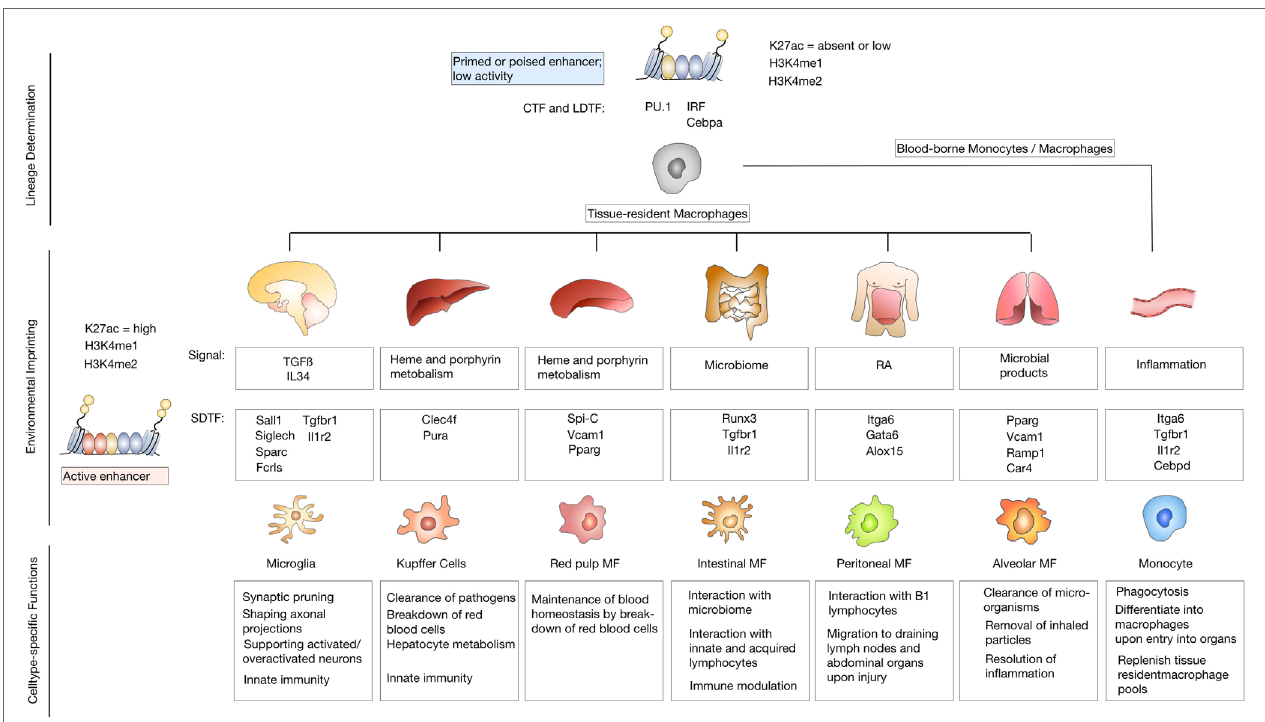
FiGURe 2 | Environmental imprinting of tissue-resident macrophages. Differentiation of precursor cells into specific lineages is determined by binding of lineage- determining transcription factors (LDTFs) and collaborating transcription factors (CTFs) to closely spaced recognition patterns on the DNA. Binding of LDTFs and CTFs selects enhancers as primed or poised. Primed enhancers are marked with characteristic histone modifications such as histone lysine 4 monomethylation (H3K4me1) or dimethylation (H3K4me2). Poised enhancers are defined by the presence of histone H3 lysine 27 trimethylation (H3K27me3). Primed or enhancers show low activity due to the lack of enhancer RNA production or the presence of H3K27me3, that has to be removed to induce an active enhancer state (upper panel). Tissue-resident macrophage populations are exposed to unique environmental cues that lead to genetic and epigenetic imprinting based on signal-dependent transcription factors (SDTF) that bind and activate primed or poised enhancers. Active enhancers are marked by H3K4m1 or H3K4me2 and histone H3 lysine 27 acetylation (H3K27ac) (middle panel). Environmental imprinting induces cell-type-specific functions of different tissue-resident macrophage populations (lower